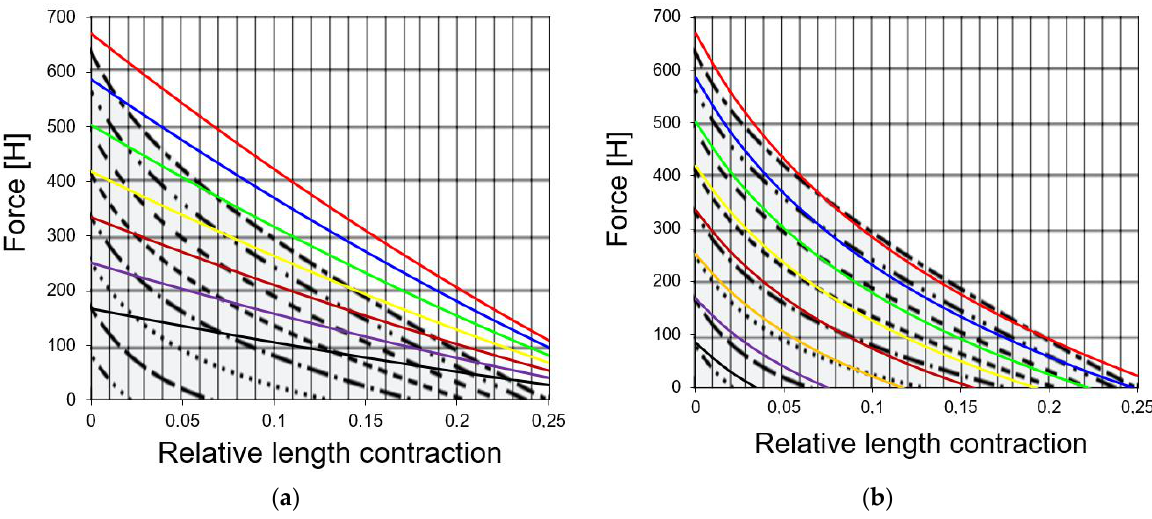
Figure 2. Dependence of the pneumatic muscle force on the relative contraction for DMSP-10: black line at p = 0.1 MPa, violet line at p = 0.2 MPa, orange line at p = 0.3 MPa, brown line at p = 0.4 MPa, yellow line at p = 0.5 MPa, green line at p = 0.6 MPa, blue line at p = 0.7 MPa, red line at p = 0.8 MPa; ( a ) dashed curves represent the FESTO experiment, solid curves represent the calculation results for model presented in [5]; ( b ) dashed curves represent the FESTO experiment, solid curves represent the calculation results for elaborated model (1).